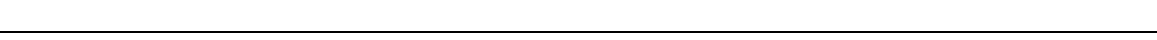
Fig. 2 Chromosome structures in TAQed yeast strains. Genome variations in the 13 TAQed strains derived from a heterozygous diploid strain (S799 and YPH499 parental strains). a Circular diagram of SNVs, InDels, short-gene conversions (SGCs, red), break-induced repairs (BIRs, black), and translocation (TLs, blue) in the 13 TAQed strains. YPH499 chromosomes, red arcs; S799, blue arcs. b Increasing ratio of canavanine-resistant colonies following TAQing treatment. The red line indicates mean of four independent experiments. * P < 0.05; Welch ’ s t -test. c Schematic diagrams of rearranged chromosomes in aneuploid TAQed strains. d Chromosome-wide mapping examples for control (black) and TAQed strains (S799, blue; YPH499, red) with a typical chromosomal rearrangement, the TL. Magni fi ed views around the TL breakpoint is shown. e TL-breakpoint sequences in fi ve TAQed strains. f Distance distribution (histogram and cumurative index curve) of randomly selected two alleles or loci pairs for TL events in the previous Hi-C data. Red and blue dots represent loci pairs for C-NHEJ-mediated and HR-mediated TLs, respectively. g 3D location of loci pairs associated with TL events. Red and blue dots linked with lines represent loci pairs for C-NHEJ-mediated and HR-mediated TLs,